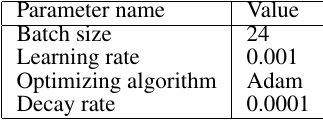
Table 2. PointNet parameter configurations